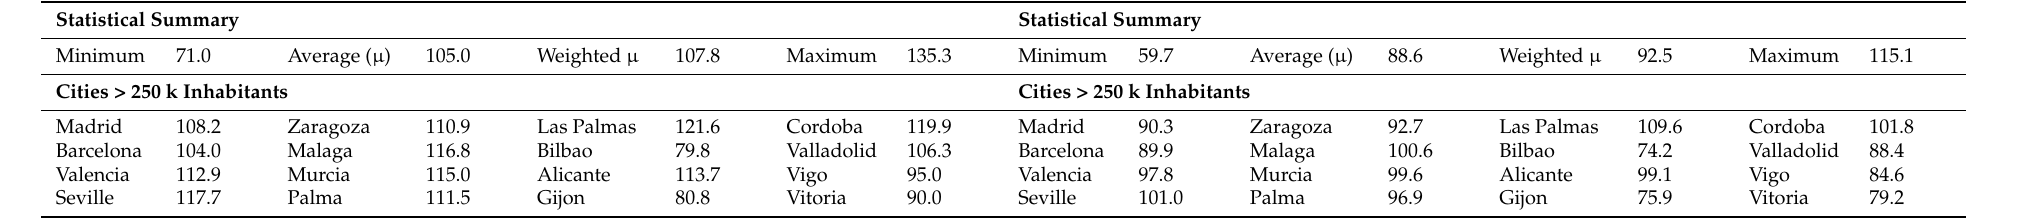
Figure 4. Contribution to electricity consumption in % excluding DHW (PV left ), and contribution to DHW consumption (ST right ).